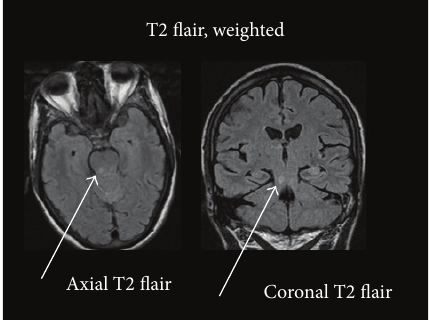
Figure2:ImagesshowT2hyperintensefocusintheposterioraspect of the midbrain-pons junction.